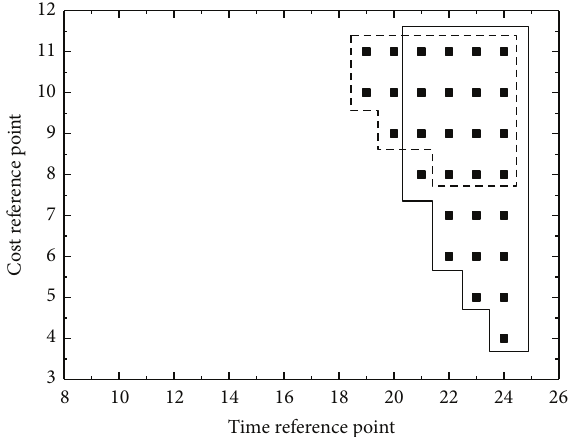
Figure 13: Possible reference points of carpooling success with traffic congestion rate 0.75.